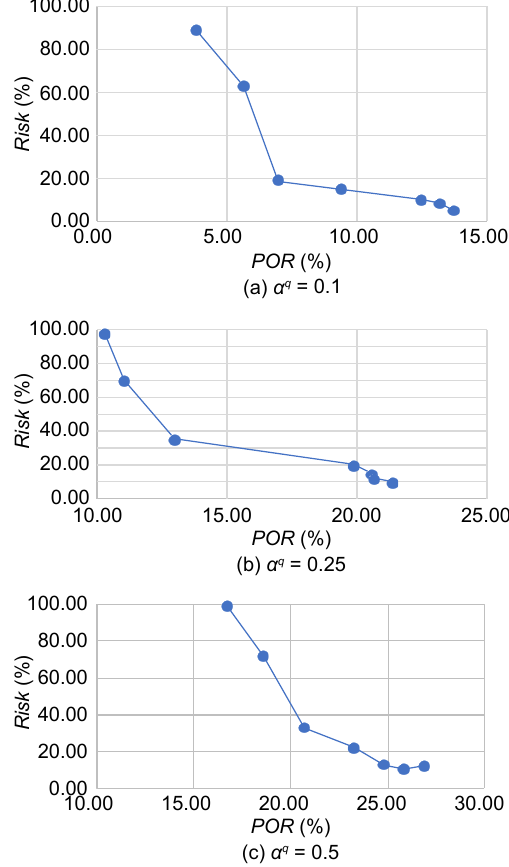
Fig. 3 POR vs. Risk when α q takes different values.